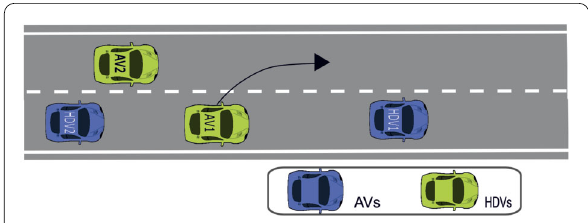
Figure 1 Illustration of the considered lane-changing scenario (green: AVs, blue: HDVs, arrow curve: a possible trajectory of the ego vehicle AV1 to make the lane